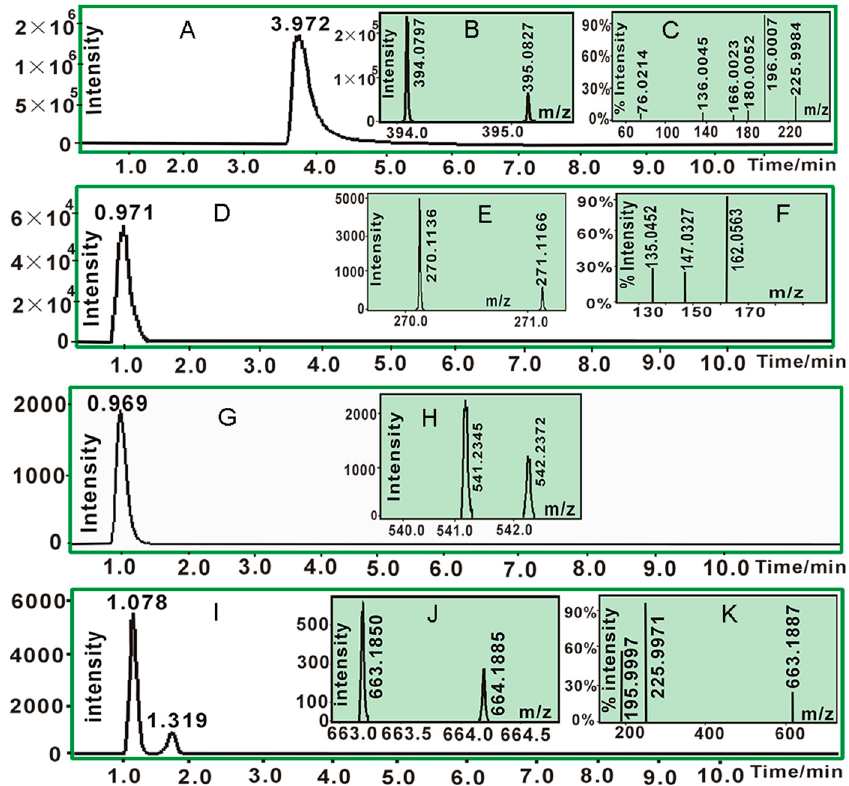
Figure 2. The main results of UPLC-ESI-Q-TOF-MS/MS analysis: ( A ). Chromatogram of 1,1-diphenyl-2-picryl-hydrazl radical ( DPPH•) when the formula [C 18 H 12 N 5 O 6 ] was extracted; ( B ). MS spectrum C of DPPH•; ( C ). MS/MS spectrum of DPPH•; ( D ). chromatogram of higenamine when the formula [C 16 H 17 NO 3 ] was extracted; ( E ). MS spectrum of higenamine; ( F ). MS/MS spectrum of higenamine; ( G ). chromatogram of higenamine-higenamine when